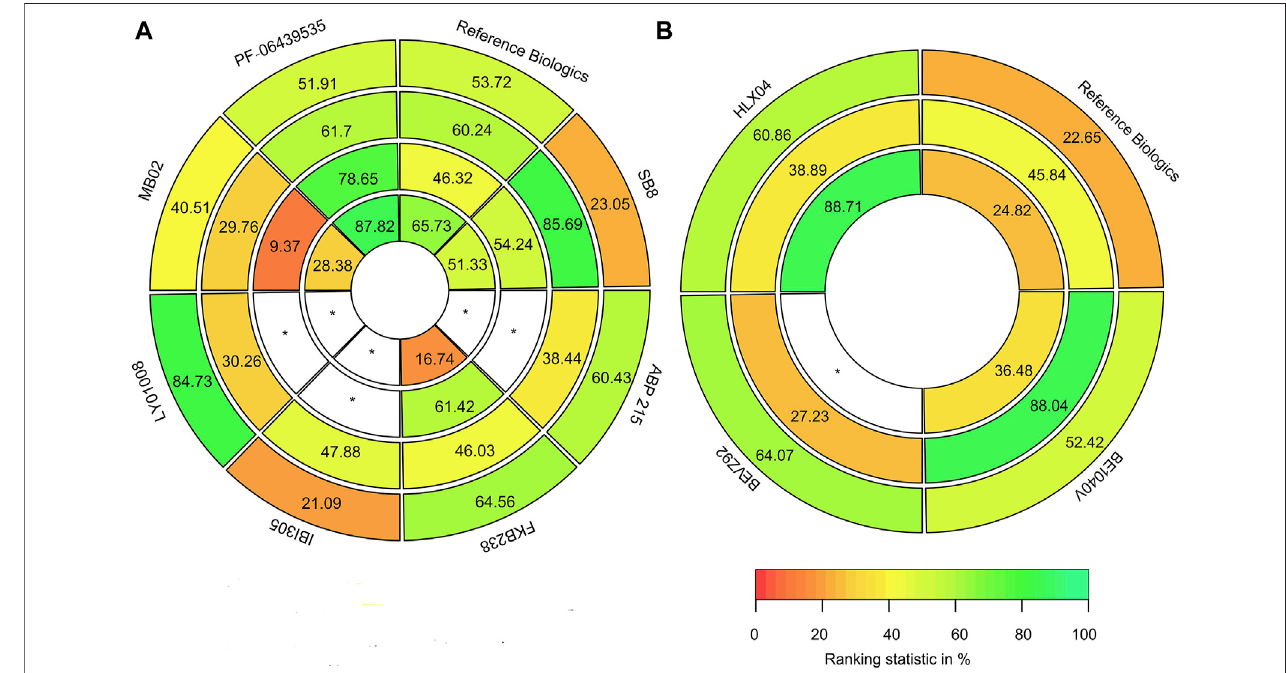
FIGURE8 | Rank-heat plot based on the surfaceunder thecumulative ranking curve (SUCRA). (A) Fornon-smallcell lung cancer patients,the index with theouter ringtotheinnerringwastheincidencerateofgrade3 – 5adverseevents,objectiveresponserate,progression-freesurvival,andoverallsurvival. (B) Forcolorectalcancer patients,the index withthe outer ring totheinner ring wasthe incidence rateofgrade 3 – 5 adverse events, objectiveresponse rate, progression-free survival, and overall survival. The scale comprises three color transformations: red (0%), yellow (50%), and green (100%), each color corresponding to a different evaluation indicator. The digits of sectors represented the SUCRA of all the outcomes. White sectors including a * represented treatments without data on the outcomes within the circle.